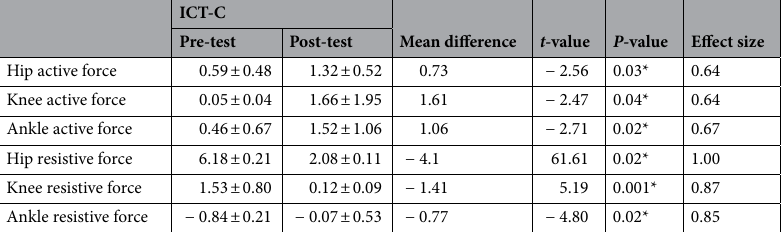
Table 2. Comparison of active force data in the paretic limb in ICT-C (unit: N). ICT-C ankle–knee–hip interlimb coordinated humanoid robot combined with conventional physical therapy; *Denotes significance at P < 0.05.